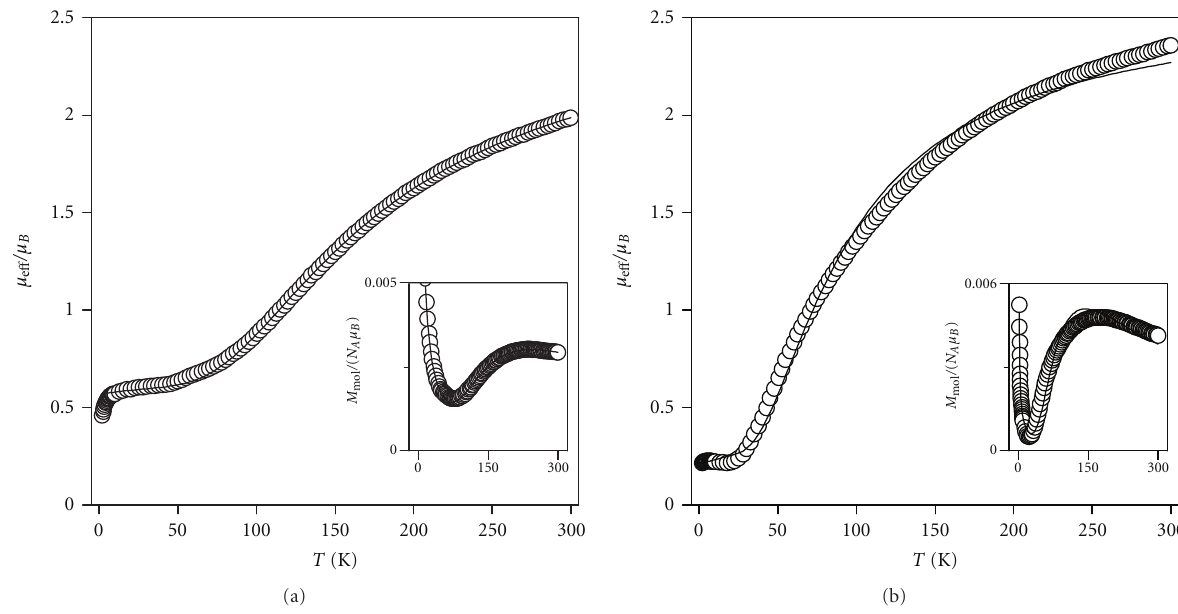
Figure 5: The magnetic data for complexes 1 (a) and 2 (b): the temperature dependence of the e ff ective magnetic moment and molar magnetization measured at B = 1 T (inset). Empty circles: experimental data, full lines: calculated data using (1) and J = − 290 cm − 1 , g = 2 . 03 and x PI = 5 . 2% for 1 and J = − 162 cm − 1 , g = 2 . 05, and x PI = 0 . 7% for 2 .